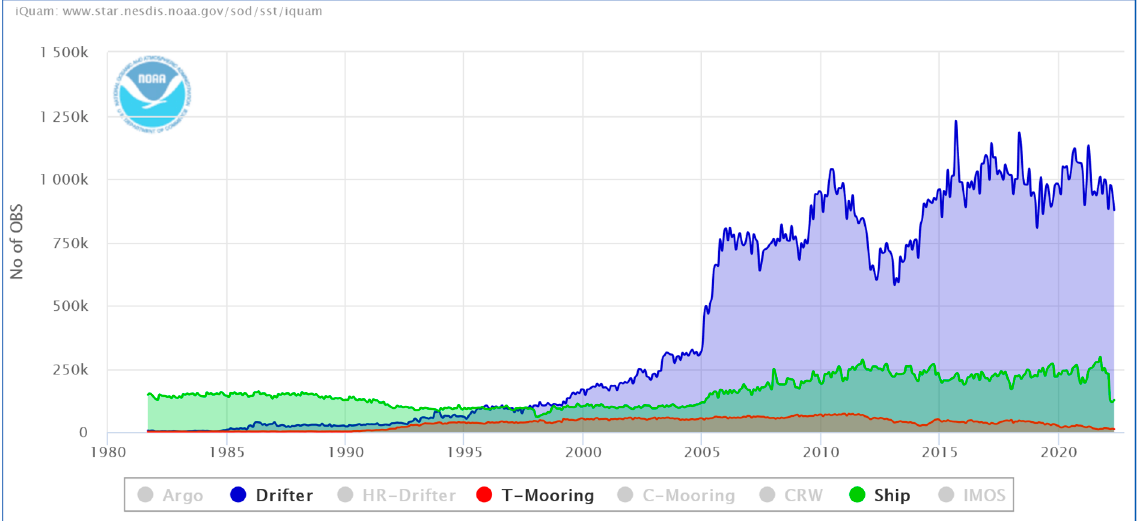
Figure 2. Time series of monthly numbers of in situ observations of different types. (From the NOAA i Quam system [18,19]). i Quam system